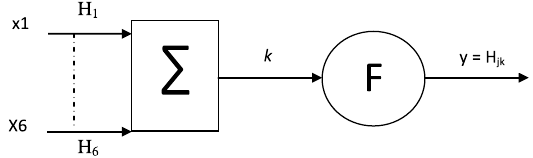
Fig. 2. Block diagram for Arti¯cial neuron model (6:3:1) for